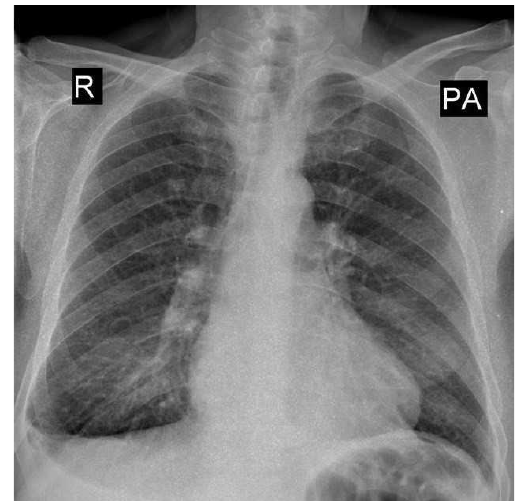
Figure 3 . Chest X-ray after